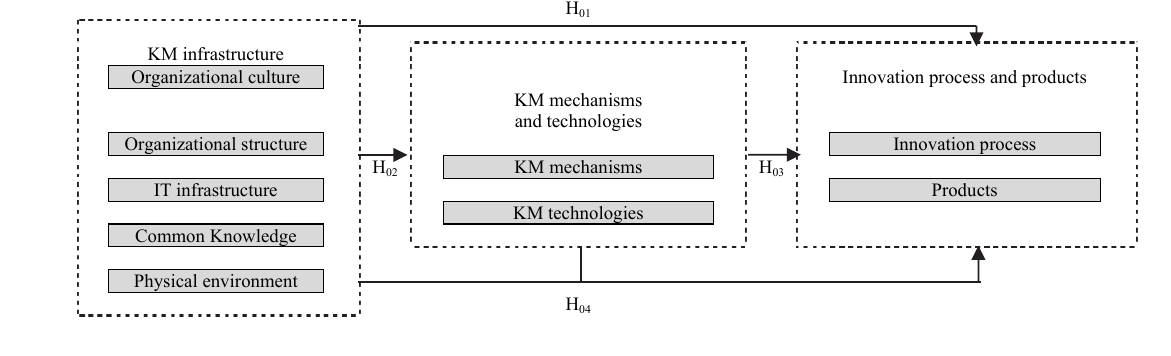
Fig. 1. The Study Model prepared by the